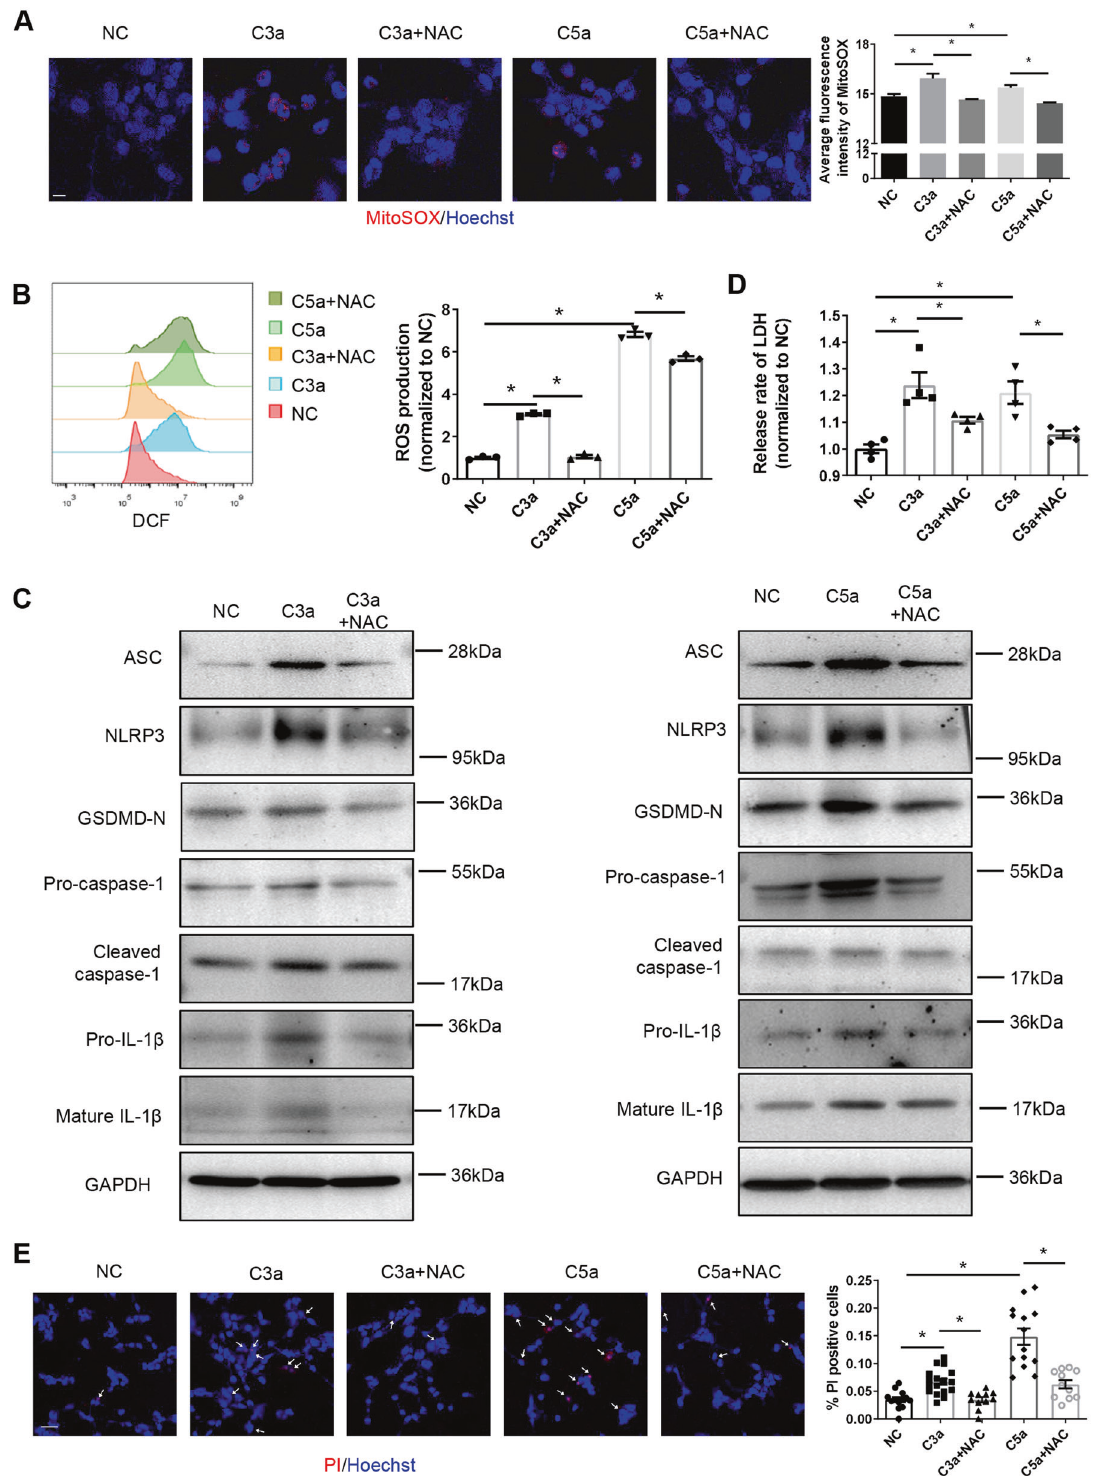
Fig. 5 Inhibition of ROS reverses complement-induced pyroptosis of podocytes. An inhibitor of ROS, NAC, was used to demonstrate that the production of mitochondrial ROS mediated C3a- or C5a-induced pyroptosis. A Representative images of mitochondrial ROS detected using MitoSOX in cultured podocytes (scale bar = 20 μ m). Quanti fi cation is shown in the right panel (11 – 18 high-power fi elds were analyzed in each group). B Production of mitochondrial ROS was detected using fl ow cytometry in cultured podocytes. Quanti fi cation is shown in the right panels. C Protein level of pyroptosis-related molecules in podocytes. D Release rate of LDH from podocytes. E Representative micro fl uorographs of PI staining in podocytes (scale bar = 50 μ m). Quanti fi cation is shown in the right panel (11 – 17 high-power fi elds were analyzed in each group). The data in ( B ) represent the mean ± SEM of three independent experiments. * p < 0.05. The data in ( D ) represent the mean ± SEM of four independent experiments. * p < 0.05.